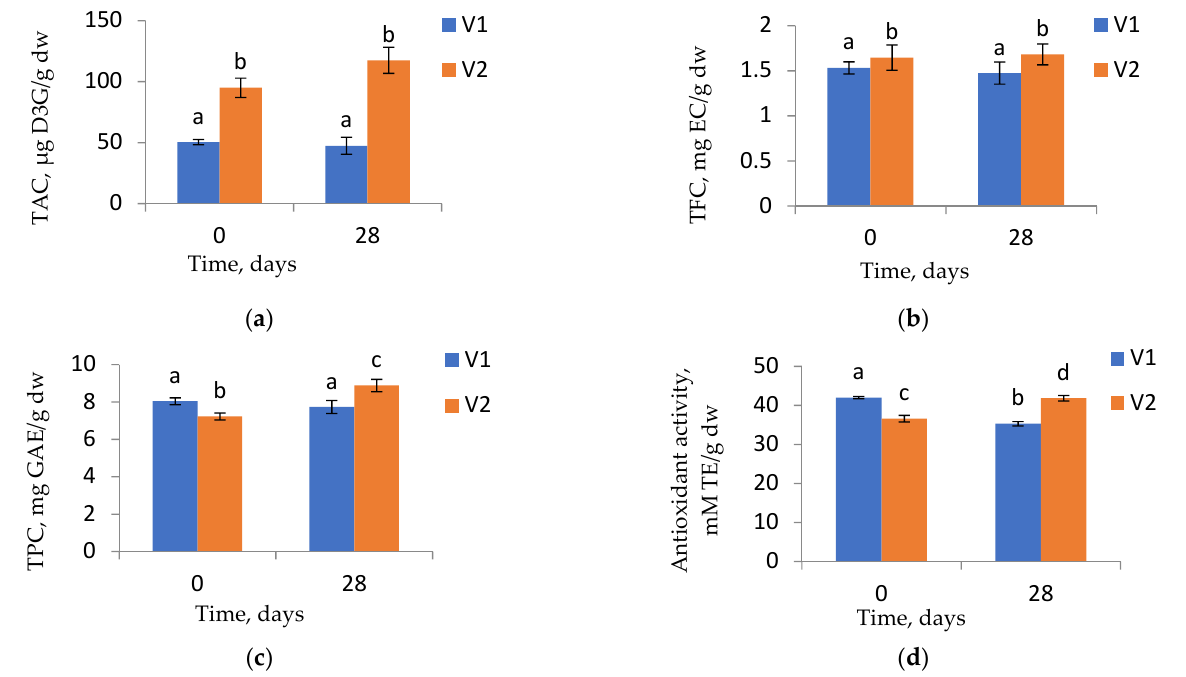
Figure 3. The TAC ( a ), TFC ( b ), TPC ( c ), and antioxidant activity ( d ) stability of the encapsulated powders after 28 days of storage at room temperature. For each tested phytochemical and powder variant, columns that do not share a letter are statistically different p < 0.05. TAC—Total Anthocyanin Content; TFC—Total Flavonoid Content; TPC—Total Polyphenol Content.